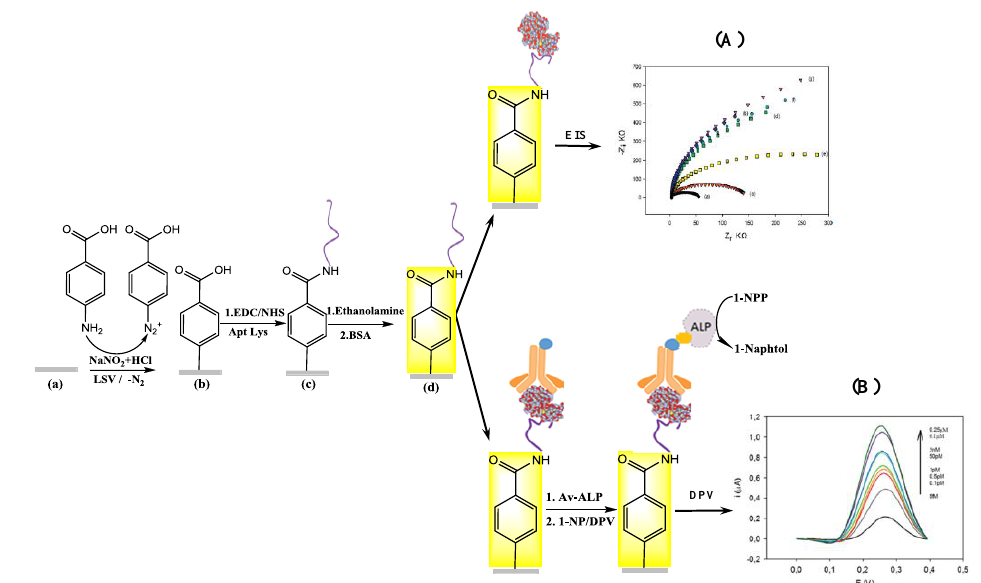
Figure 5. ( A ) Surface modification scheme and Nyquist plots for bare electrode (a), modified with diazonium salt (b), after EDC/NHS (c), functionalization with aptamer (d), after ethanolamine/BSA blocking (e) and after interaction with lysozyme (f) using PBS solutions containing [Fe(CN) 6 ] 4−/3− (2 mM) [63]; ( B ) surface modification and DPV signal after incubation with anti-lysozyme antibody and avidin-ALP coupling via biotin-avidin affinity for lysozyme sensing (reprint with permission from [44]).